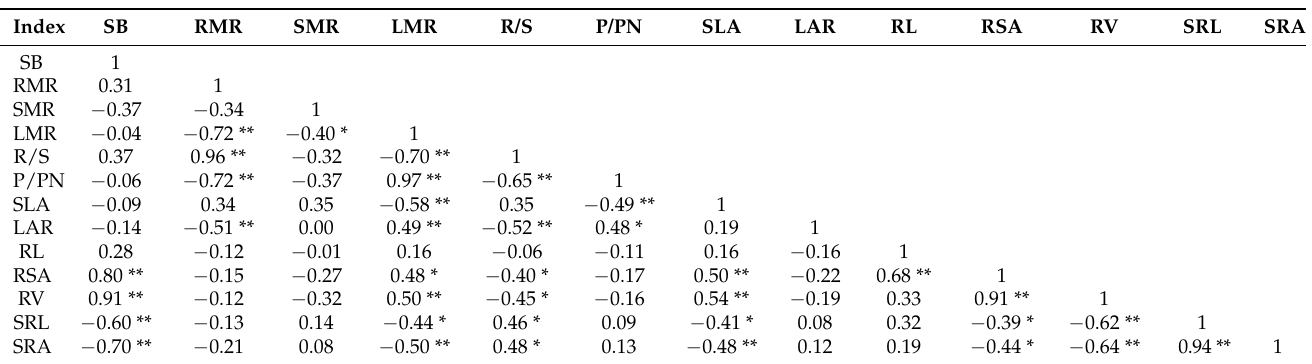
Table 3. Correlation analysis among seedling characteristics of Quercus acutissima . SB: seedling